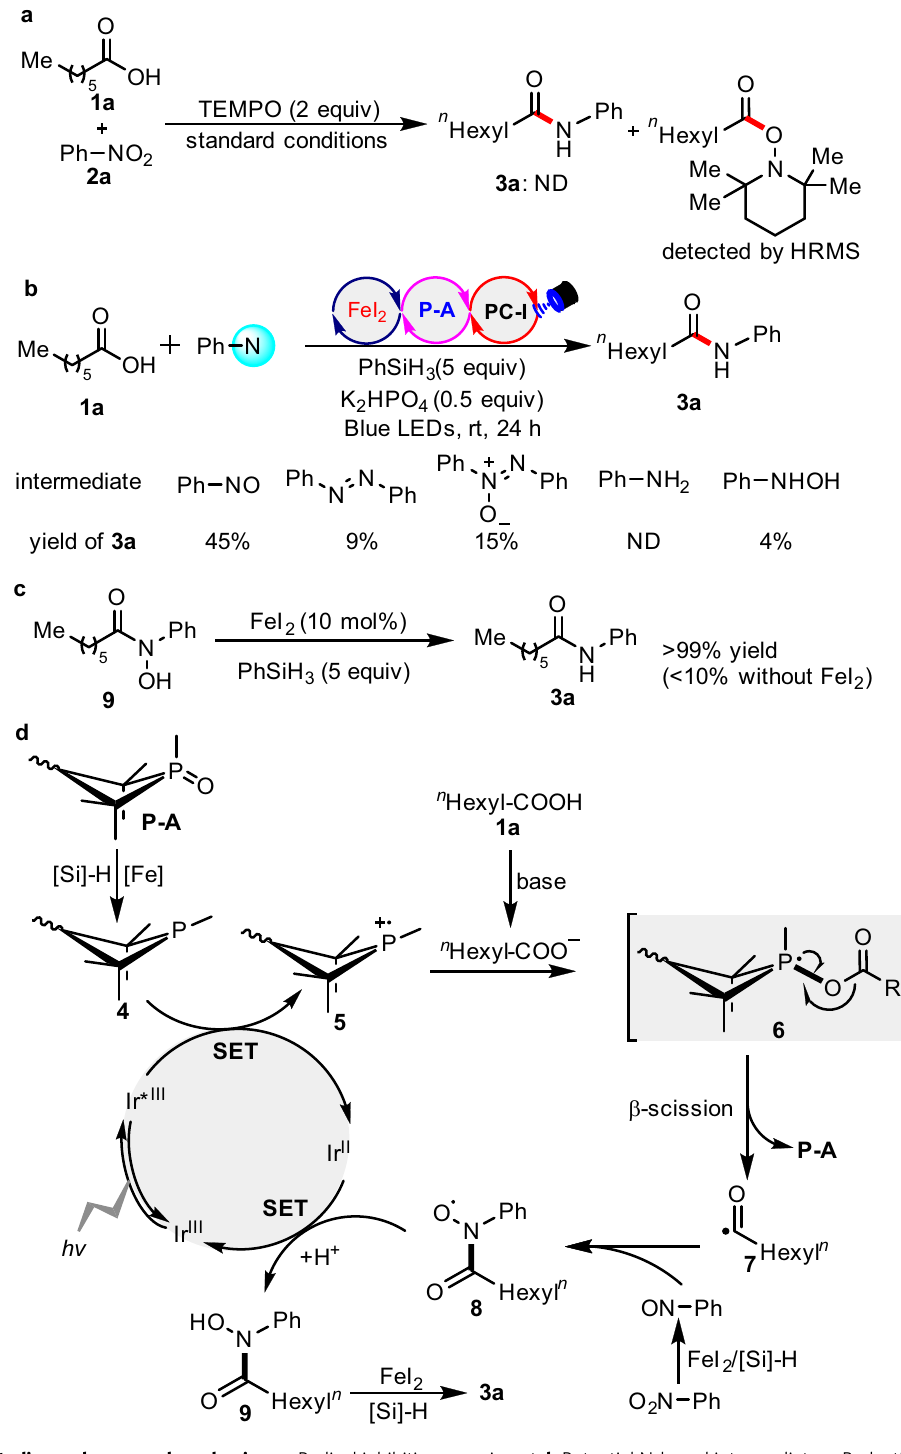
Fig. 5 Mechanistic studies and proposed mechanism. a Radical inhibition experiment. b Potential N-based intermediate. c Reduction of 9 to product 3a . d Proposed